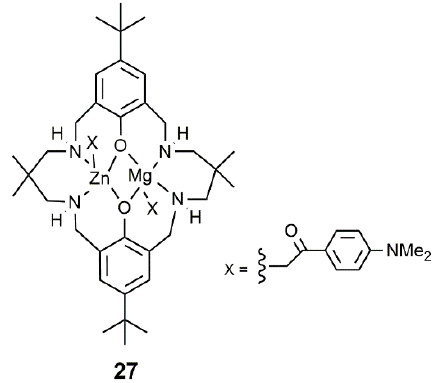
Figure 10. Heterodinuclear Zn/Mg catalyst 27 [52].